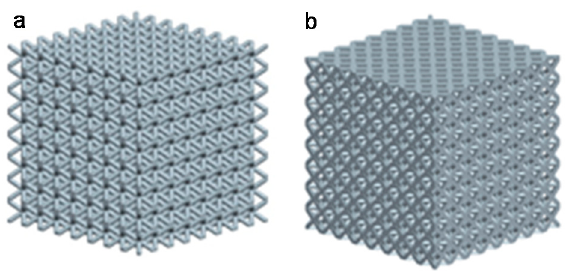
Figure 5. Schematic diagram of three-dimensional (3D) model of finite element analysis (FEA): ( a ) BCC; ( b ) AFCC.